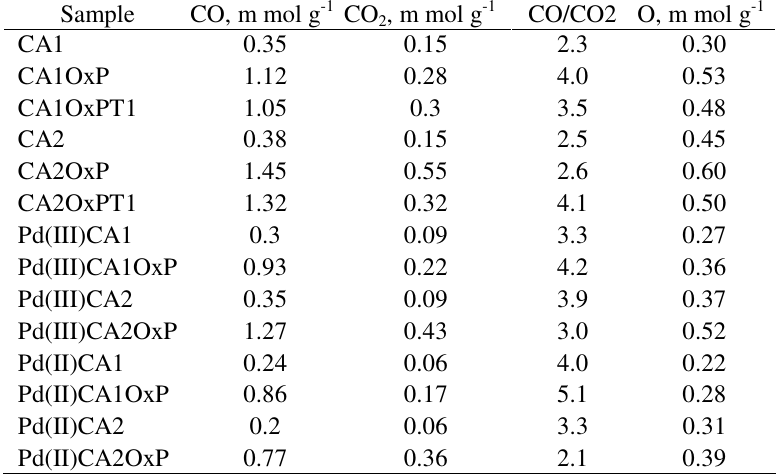
Figure. 3. TPD Profiles for CO of the CA1 supports. 2 Table 2. TPD of the catalysts on the activated carbons with different oxidation